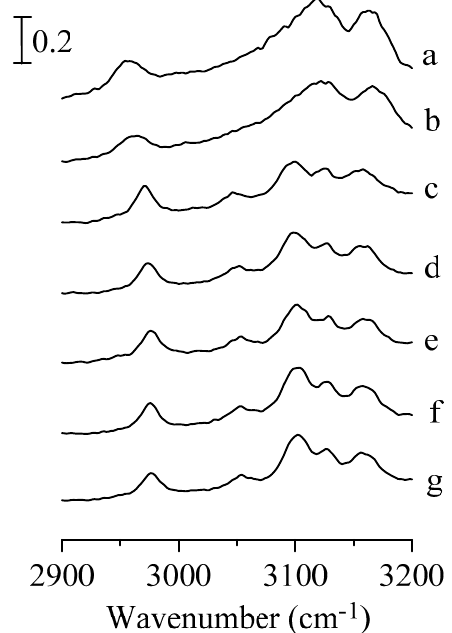
Figure 1. Infrared spectra of pure 1,3-dimethylimidazolium methyl sulfate obtained under ambient pressure (curve a) and at 0.4 (curve b), 0.7 (curve c), 1.1 (curve d), 1.5 (curve e), 1.8 (curve f), and 2.5 GPa (curve g).